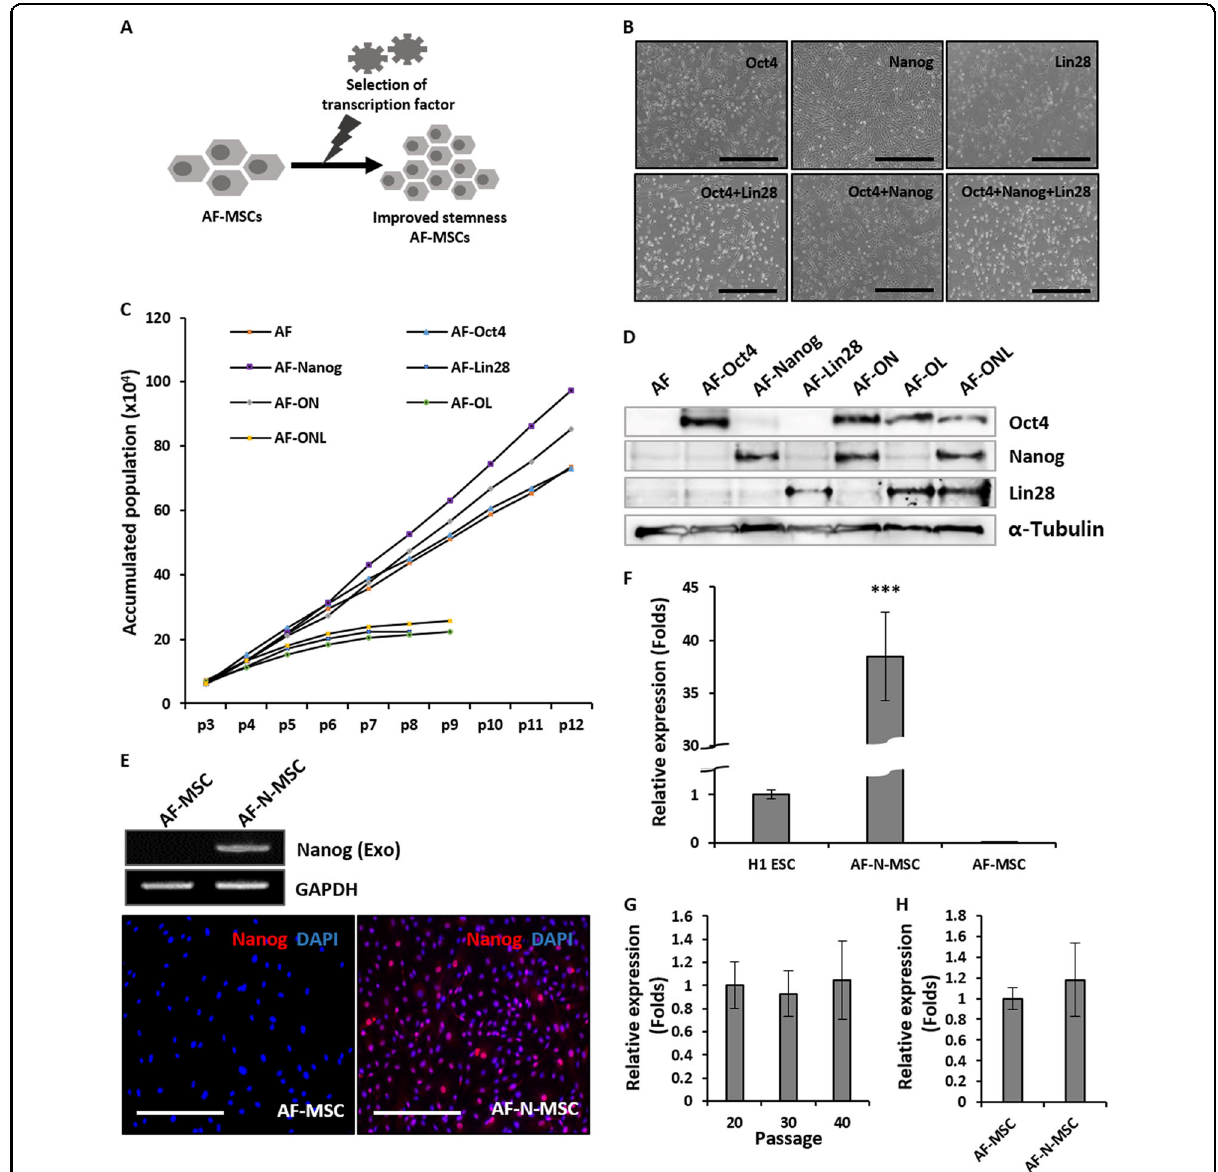
Fig. 1 Forced expression of pluripotency-related transcription factors in amniotic fl uid – derived mesenchymal stem cells (AF-MSCs). a Schematic of the process for selecting a key transcription factor to promote stemness of AF-MSCs. b Morphological changes and c growth rate of AF-MSCs infected with retroviral vectors encoding Oct4, Nanog, and Lin28, alone or in combination. Scale bar, 1 mm. d Expression of transcription factors, alone or in combination, as determined by western blotting. e Overexpression of exogenous Nanog in AF-MSCs, detected by reverse transcriptase – polymerase chain reaction (RT-PCR) and immuno fl uorescence. Scale bar, 1 mm. f Nanog expression in H1 embryonic stem cells, AF- MSCs overexpressing Nanog (AF-N-MSCs), and AF-MSCs. g Expression of Nanog in AF-N (infected at 10 passages) over 40 passages. h Expression of endogenous Nanog in AF-N-MSCs, detected by quantitative real-time RT-PCR. Data are represented as the mean ± SD ( n = 3). *** p <